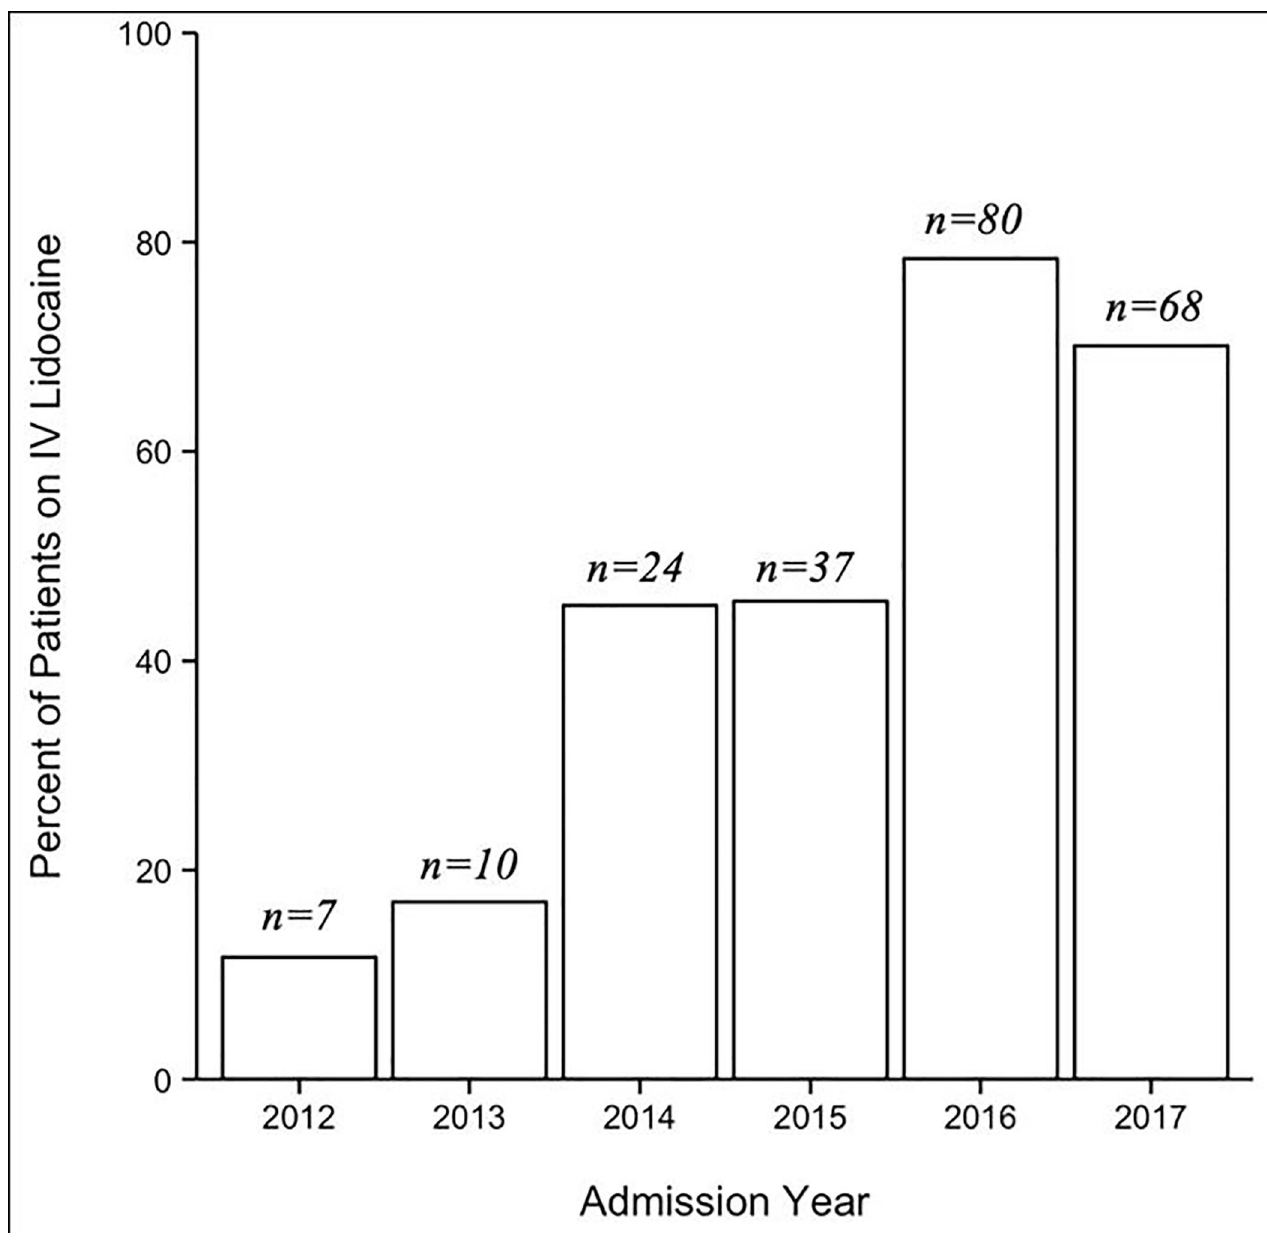
Fig 1. Increase in intravenous lidocaine use over the study